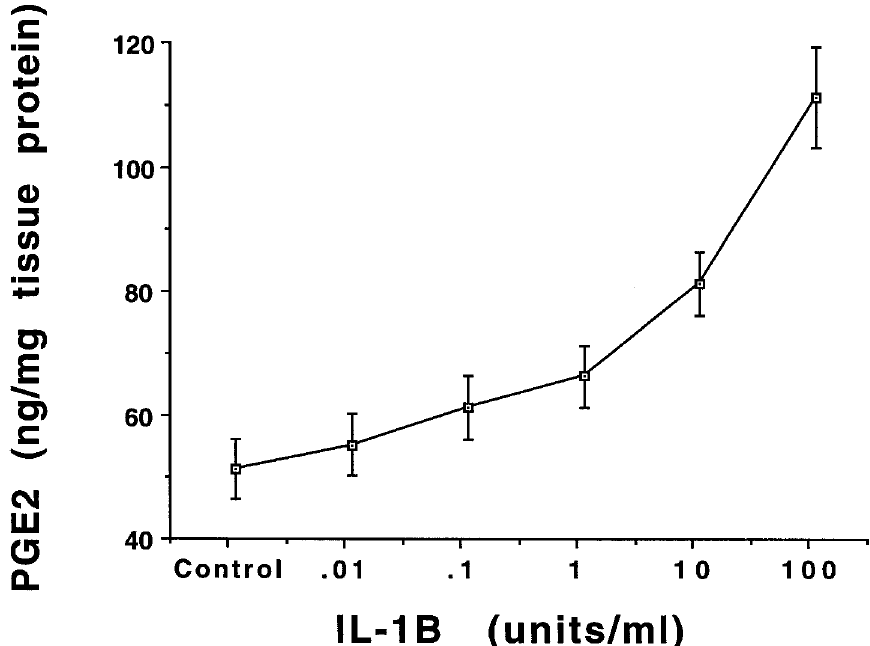
FIG. 2. Dose response evaluation of IL-1 b stimulated PGE 2 formation in HISM cells 1 3 10 6 HISM cells were exposed to varying concentrations of IL-1 b for 4h. Each point represents the mean ± SEM of 6 values obtained from duplicate measurements of PGE 2 in buffer solution from six